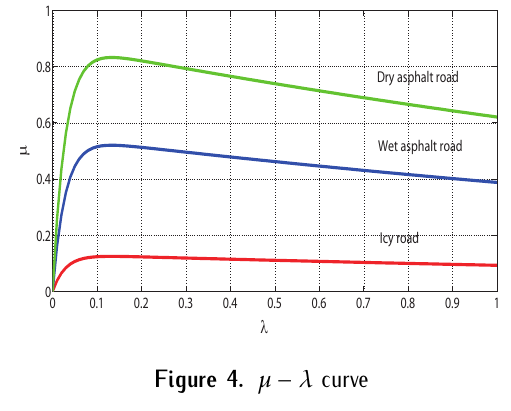
Figure 4. (cid:22) (cid:0) (cid:21)